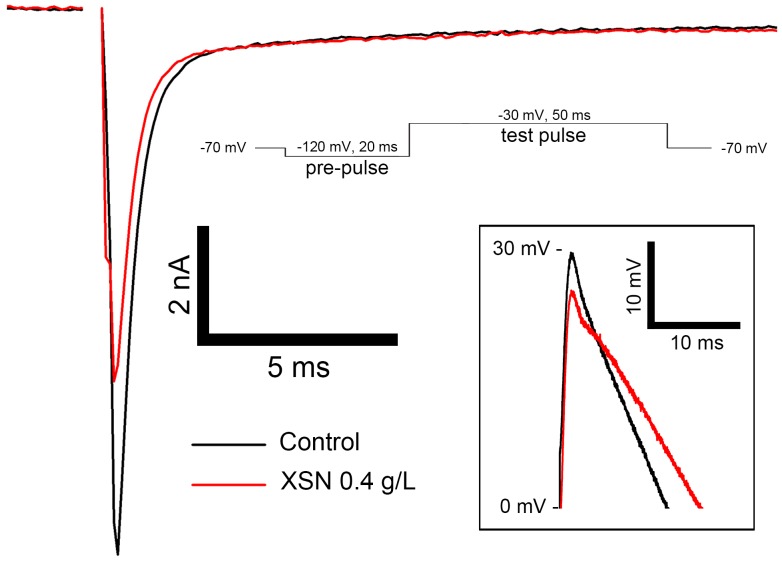
Effect of 0.4 g/L XSN on inhibition of peak Na+ current on primary rat ventricular myocytes (n = 5). The enlarged traces of the peaks of the action potentials are shown in the box on the bottom right.